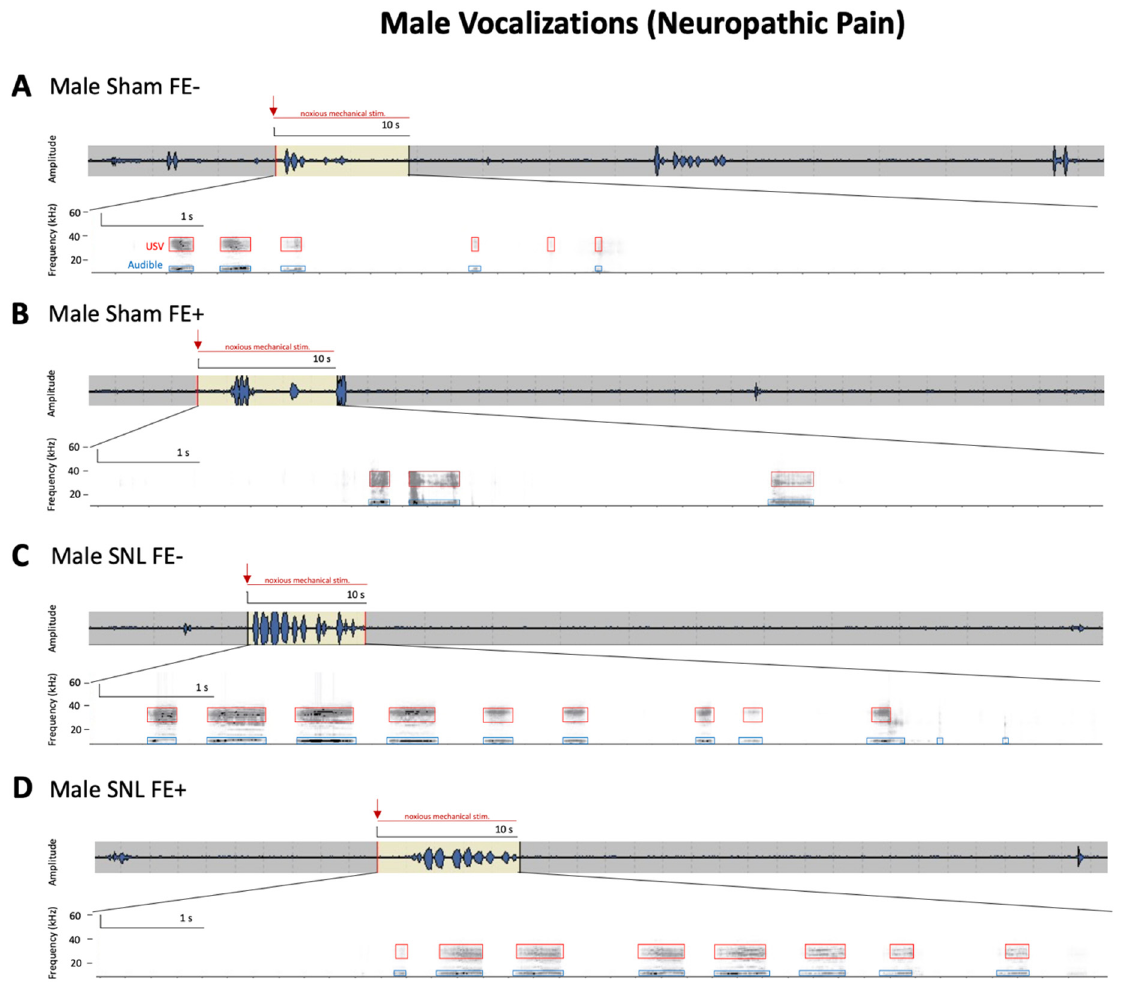
Figure 6. Representative audible and ultrasonic vocalizations from phenotyped male rats in the SNL model of neuropathic pain. Original real-time waveform and spectrogram recordings of vocalizations evoked in response to brief (10 s) noxious (1500 g/6 mm 2 ) mechanical stimulation of the affected hindpaw 4 weeks after induction of sham ( A , B ) or SNL ( C , D ) surgery in phenotyped male rats. For details, see Section 2.5.3. Mechanical stimuli were applied to the hindpaw in each recording period, as indicated by the highlighted yellow section of the waveform (upper panel, red arrow indicates initiation of noxious stimulus application); the total duration of the recording is 1 min. Boxes (events) in the spectrogram (lower panel) represent the presence of audible (blue; 20 Hz–16 kHz) and ultrasonic (red; 25 ± 4 kHz) vocalizations during the 10 s application of mechanical stimuli. Male FE − sham rats ( A ) showed more vocalization events in response to noxious stimulus than male FE+ sham rats ( B ). Male FE − SNL rats ( C ) showed more vocalization events in response to noxious stimulus than male FE+ SNL rats ( D ). FE: fear extinction; SNL: spinal nerve ligation; USV: ultrasonic vocalizations.